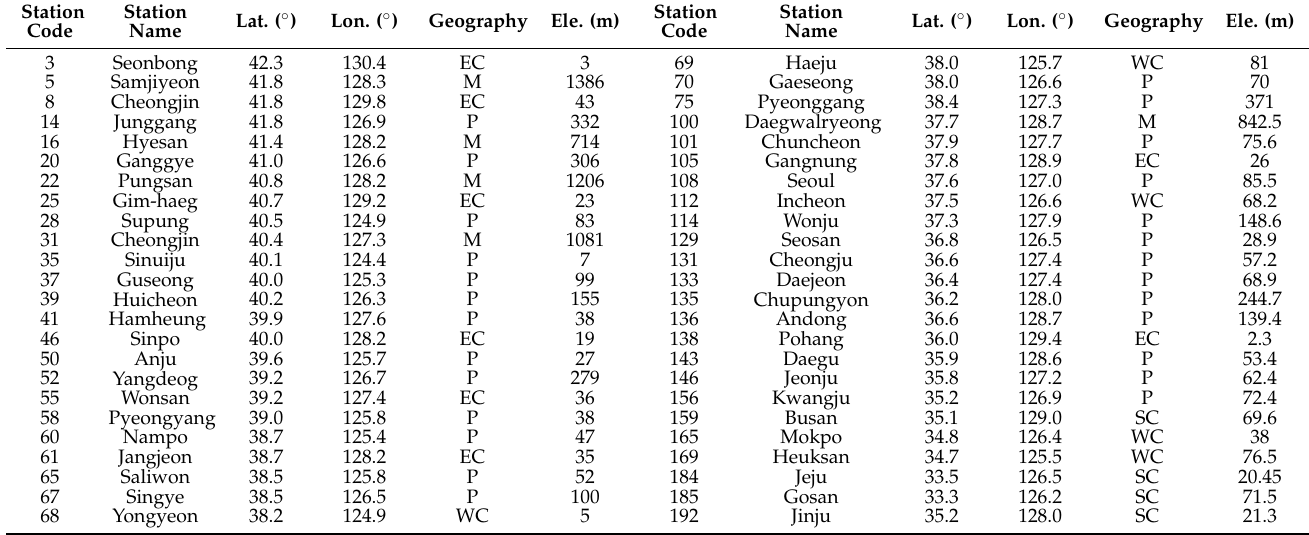
Figure 1. Study area. Table 2. Characteristics of the meteorological stations used in this study.